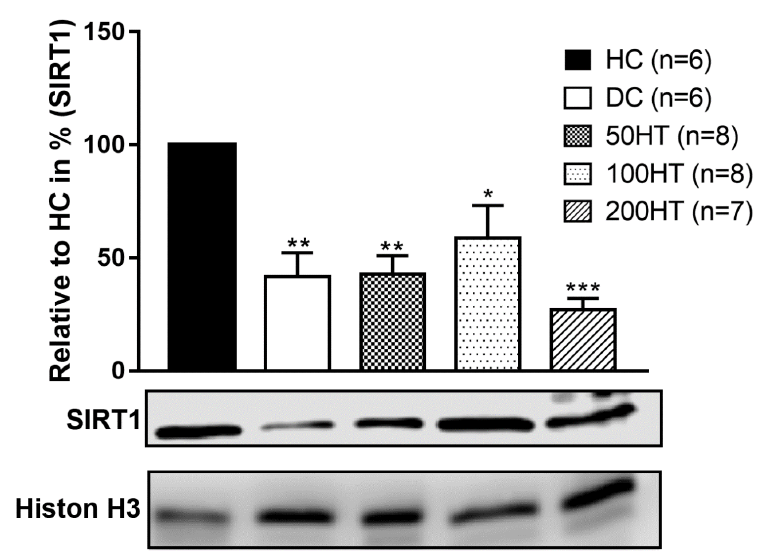
Figure 11. Effect of horsetail on SIRT1 protein expression in left ventricle cardiac tissue. The *, **, and *** indicates significant difference from HC group ( p < 0.05, p < 0.01, and p < 0.001, respectively).